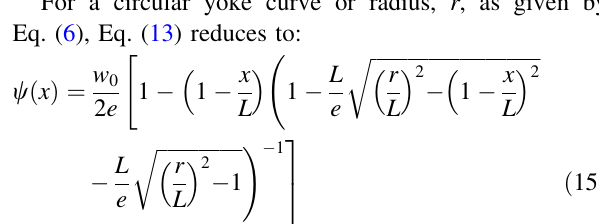
ffiffiffiffiffiffiffiffiffiffiffiffiffiffiffiffiffi r